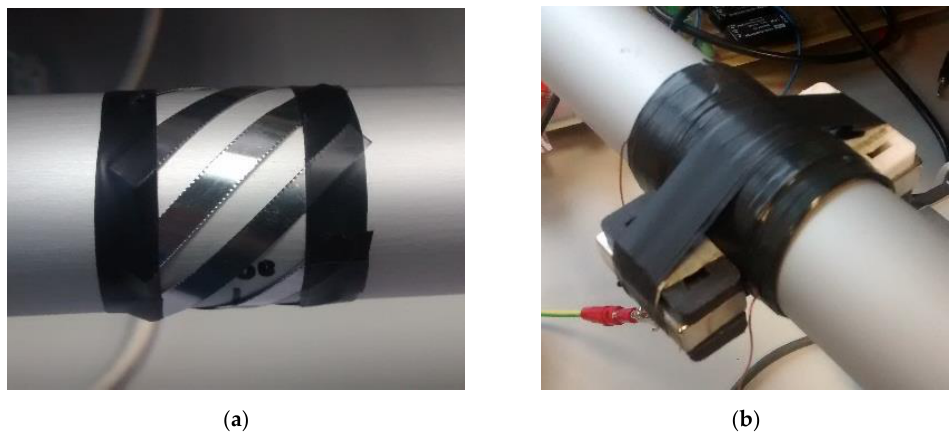
Figure 8. ( a ) Permendur strips attached around the pipe at 45°. ( b ) Transducer with coil and magnets.